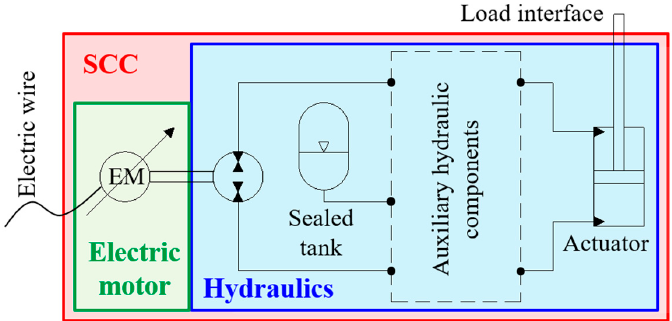
Figure 1. Simplified illustration of a self-contained electro-hydraulic cylinder.